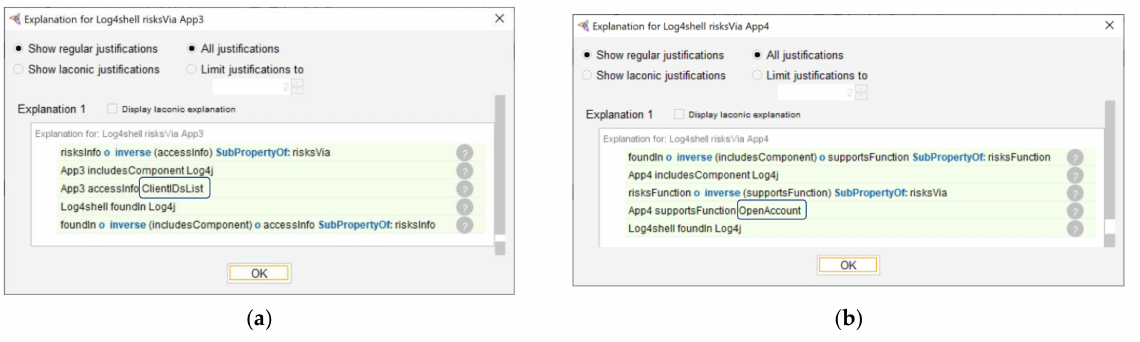
Figure 3. The reasoner explanation for asserting the risksVia properties. ( a ) for App3, as a result of the risksInfo with respect to ClientIDsList; ( b ) for App4, as a result of the risksFunction with respect to